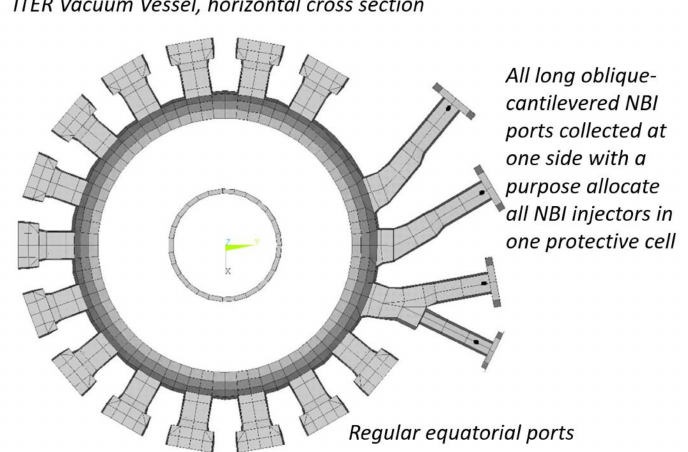
Figure 4. Long oblique-cantilevered NBI ports collected at one side of large tokamaks by design reasons cause an asymmetric dynamic response of VV to even perfectly symmetric EM excitation at VDE. This plot is from visual library of ITER IO.